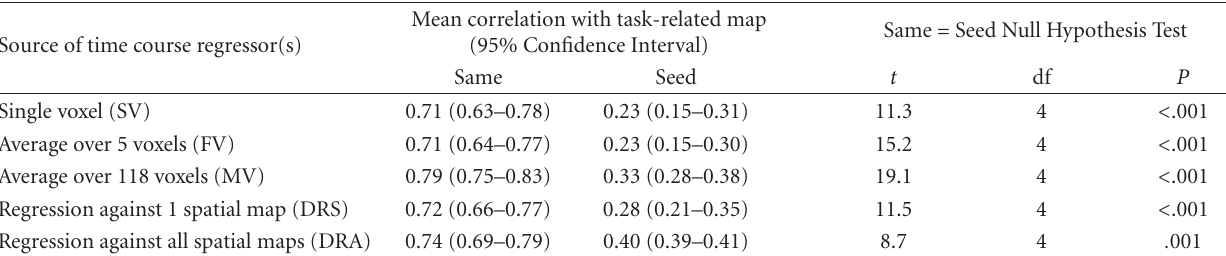
Table 1: Experiment 2: mean correlations of hybrid ICA-seed-based maps with maps from task-related GLM, over the five target (nonseed) fMRI data sets. “Same” indicates mean correlation of hybrid method FC maps with task-related GLM derived from the same fMRI dataset. “Seed” indicates mean correlation of hybrid method FC maps with task-related GLM map from Run 3’s fMRI dataset, the seed source.